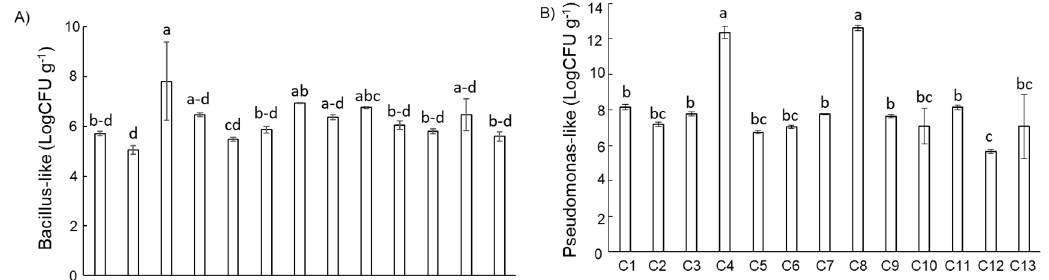
farm green composts (C1–13). Bars indicate the mean ± standard deviation. Different letters indicate significant differences according Tukey's HSD test at p ≤ 0.05.